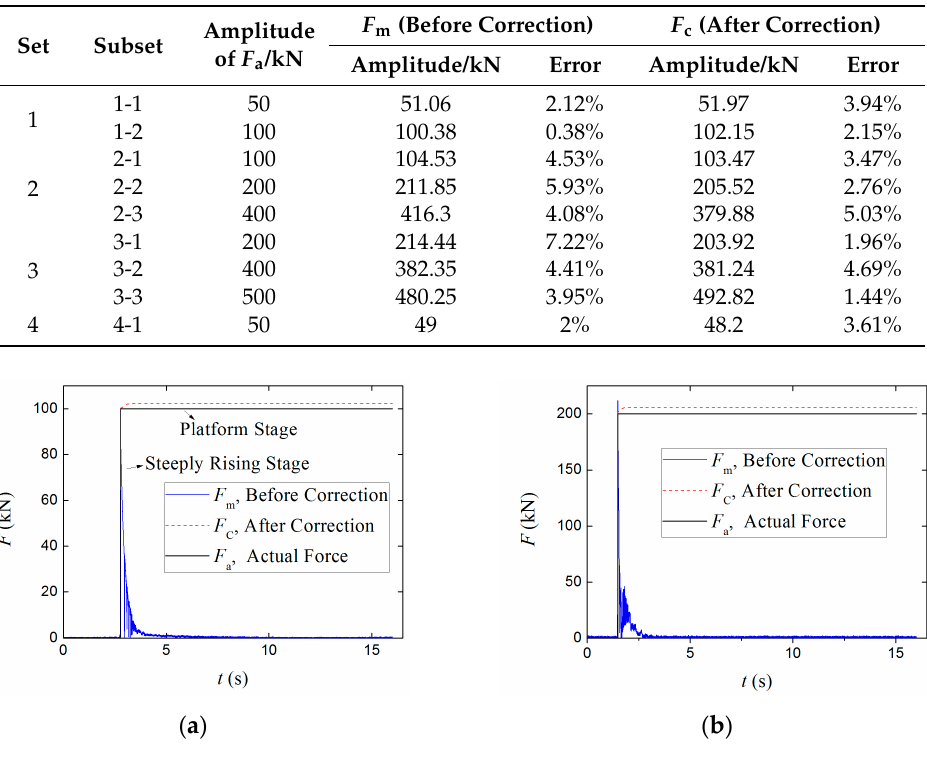
Set Table 5. Measuring errors before and after correction of the piezoelectric sensor for step force.